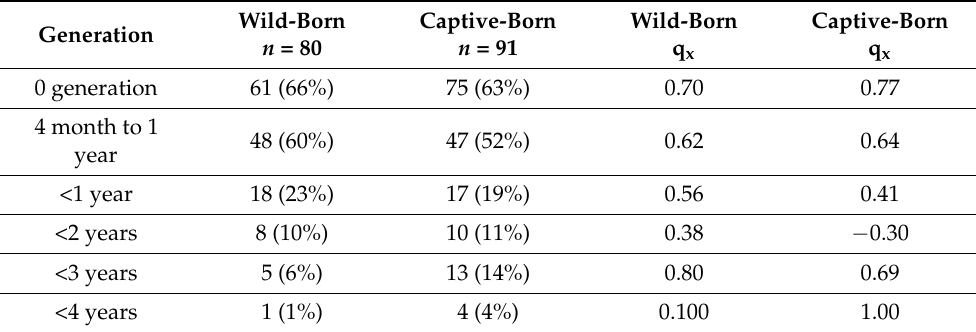
Table 2. Life table of wild-born and captive-born mink. Danish mink: n = number (percent) of mink in each age class; q x = mortality rate. The start generation (0) was calculated from the fecundity of females (Table